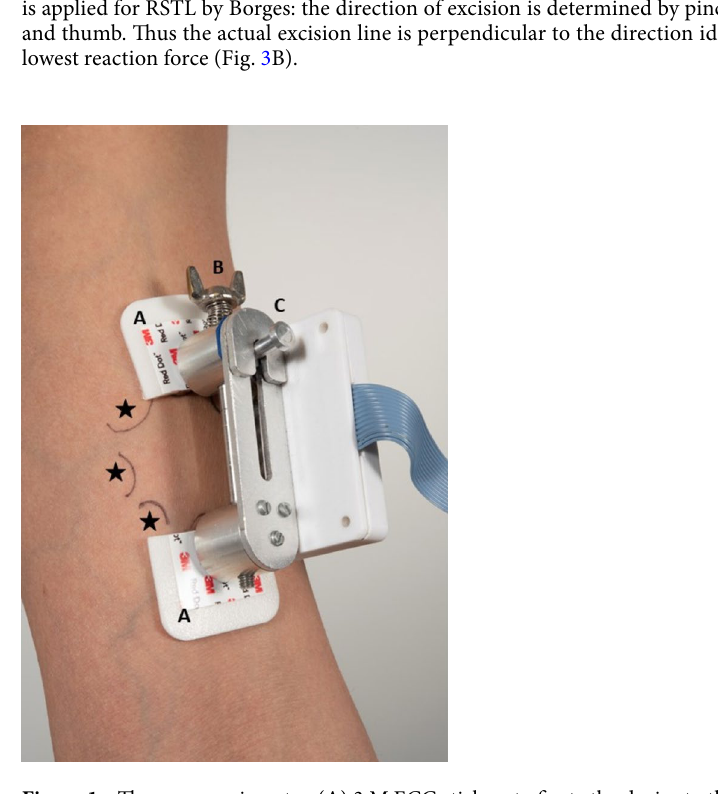
Figure 1. The compressiometer. ( A ) 3 M ECG stickers to fixate the device to the skin; ( B ) the compressed spring; ( C ) the button to release the spring; Asterisks: the locations for the 45, 90 and 135°